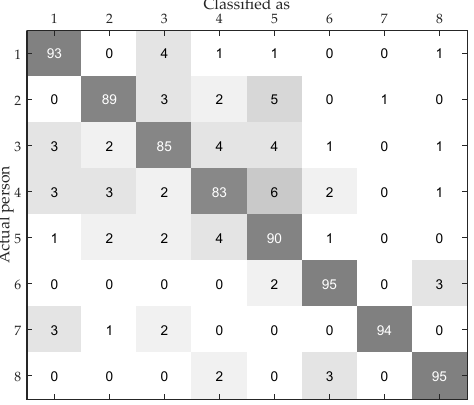
Figure 13. The confusion matrix of human identification with eight people.